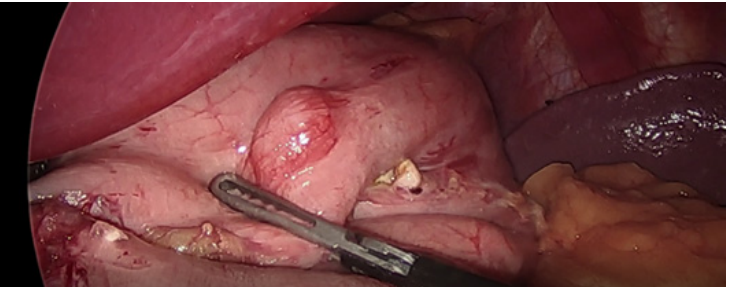
Figure 1. GIST in the fundus found intraoperatively in Patient 5. (White arrow indicates the tumor). Table 2. Characteristics of patients with histopathological results. (DM2—diabetes mellitus 2; AH— arterial hypertension; DCM—dilated cardiomyopathy; AF—atrial fibrillation; HT—hypothyroidism; BMI—body mass index; preop—preoperative; postop—postoperative; %EWL—percentage of excess weight loss).